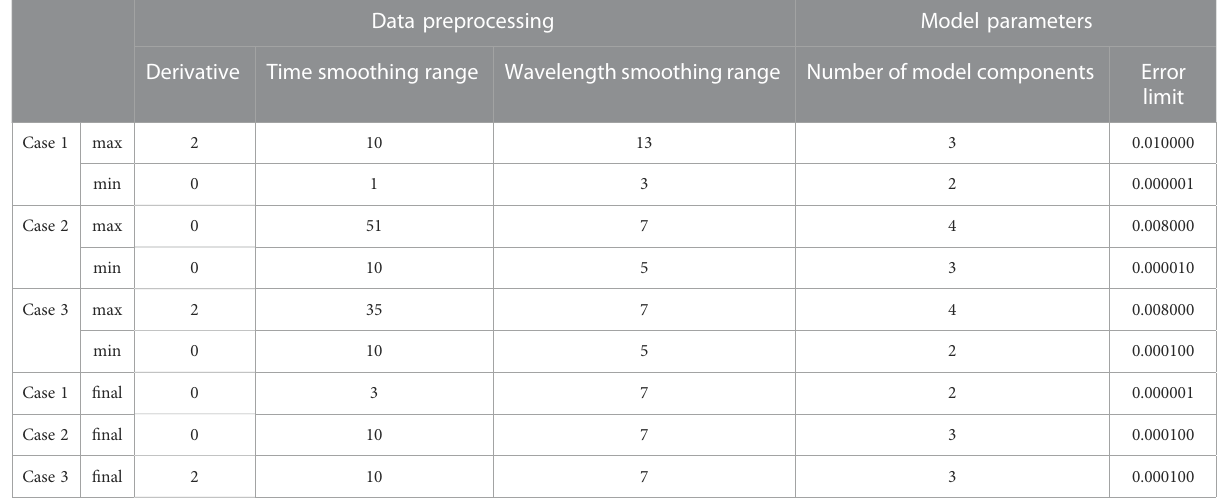
TABLE 1 Preprocessing and model development parameters: These parameters were varied for each case study to fi nd optimal calculation parameters. The fi nal calculation parameters are listed as